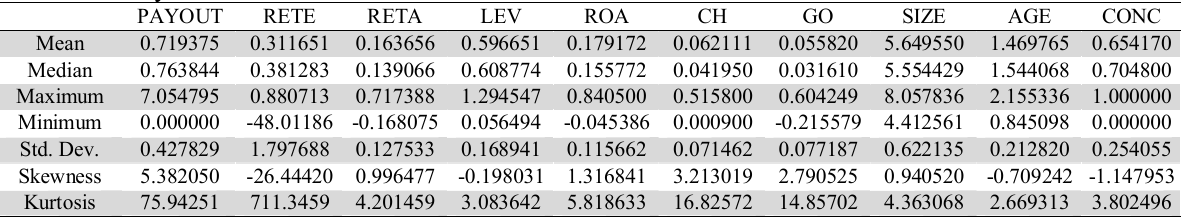
The summary of basic statistics